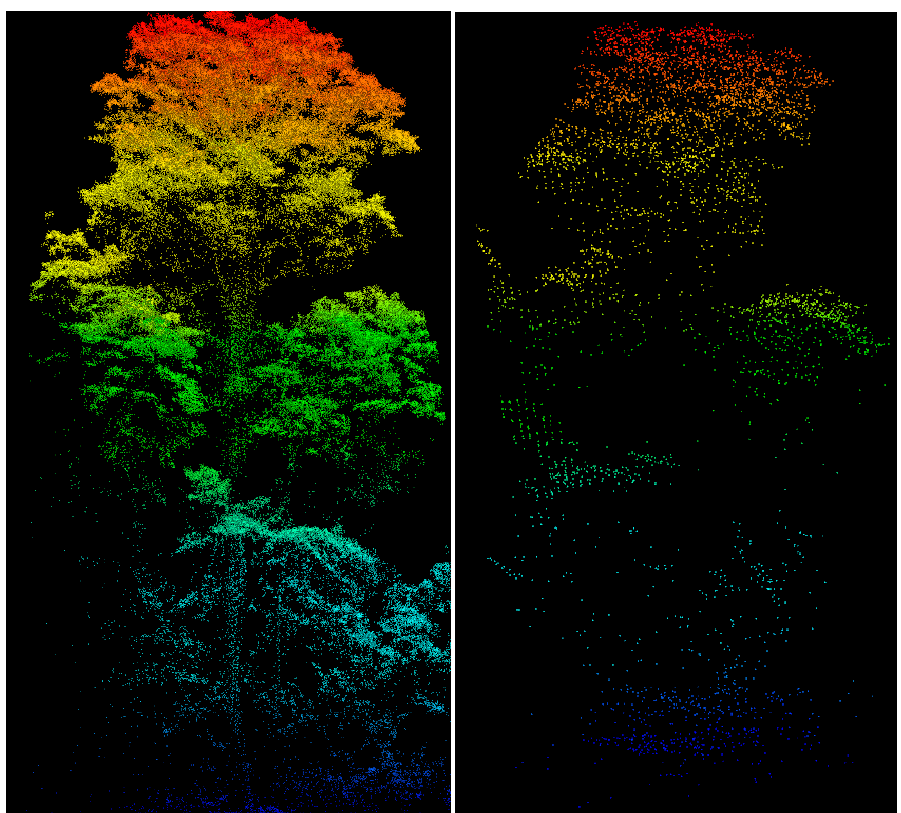
Figure 3. Example LiDAR point clouds of a canopy tree located in Permanent Sample Plot (PSP) 14 produced by the GatorEye (A) and Aircraft (B) systems, highlighting the increased crown, branch, and trunk resolution of the GatorEye system.